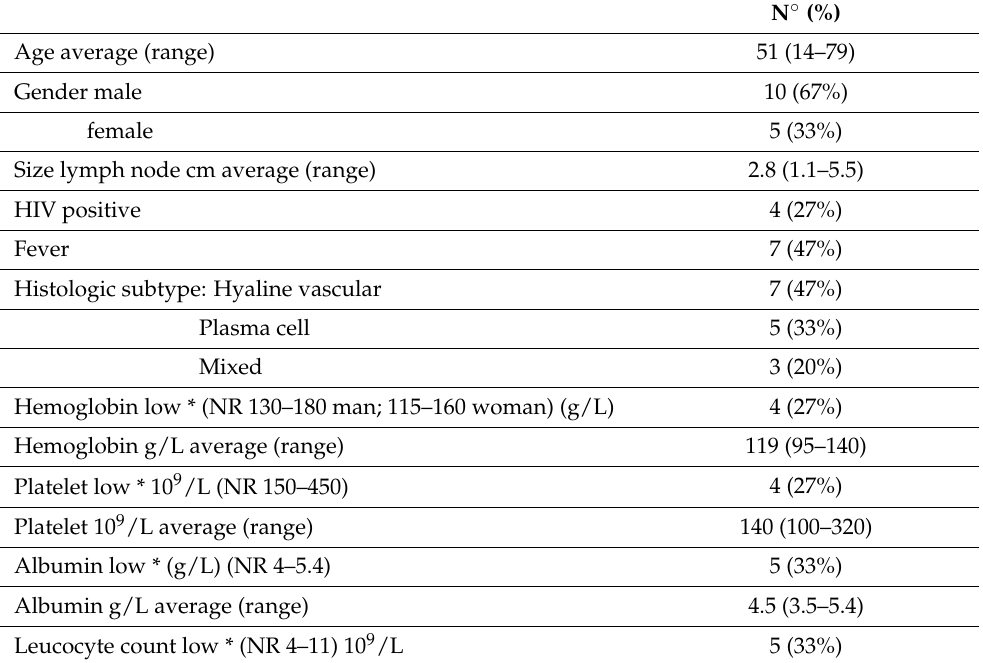
Table 1. Baseline characteristics of 15